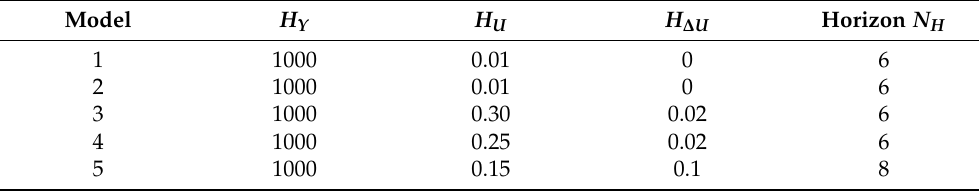
Table 1. The visual tuned weights of each control design.